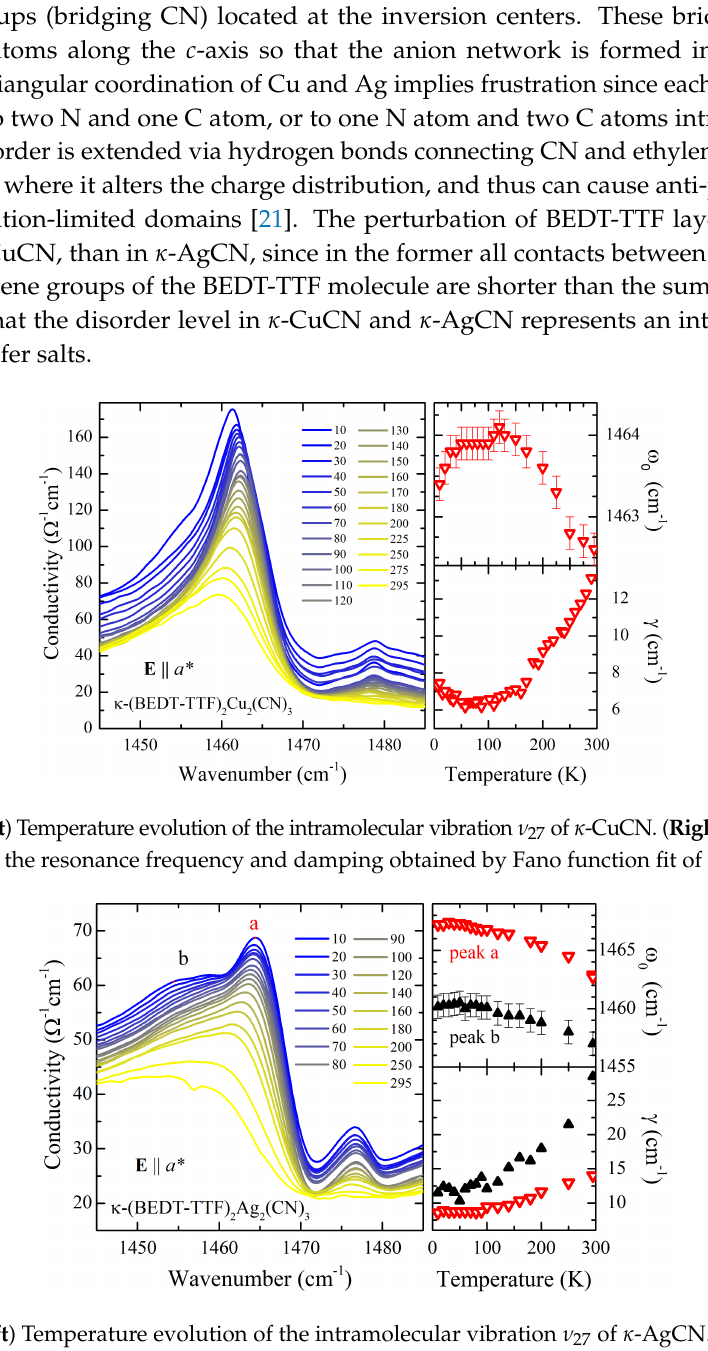
Figure 11. ( Left ) Temperature evolution of the intramolecular vibration ν 27 of κ -AgCN. The two Fano functions required to fit the spectra indicate two crystallographically distinct sites. ( Right ) Temperature dependence of the resonance frequency and damping obtained by the fit using two Fano